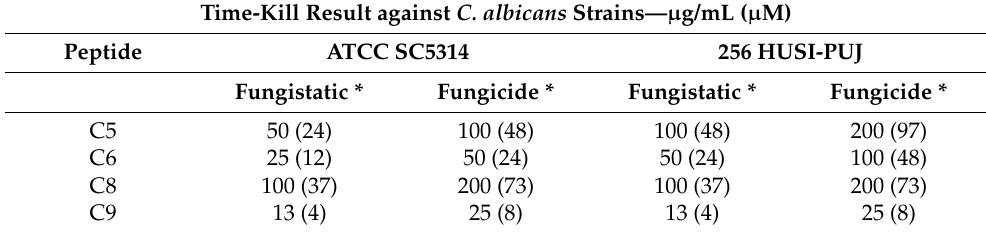
Table 2. Fungistatic and fungicide effect values for chimeras with higher activity against C. albicans